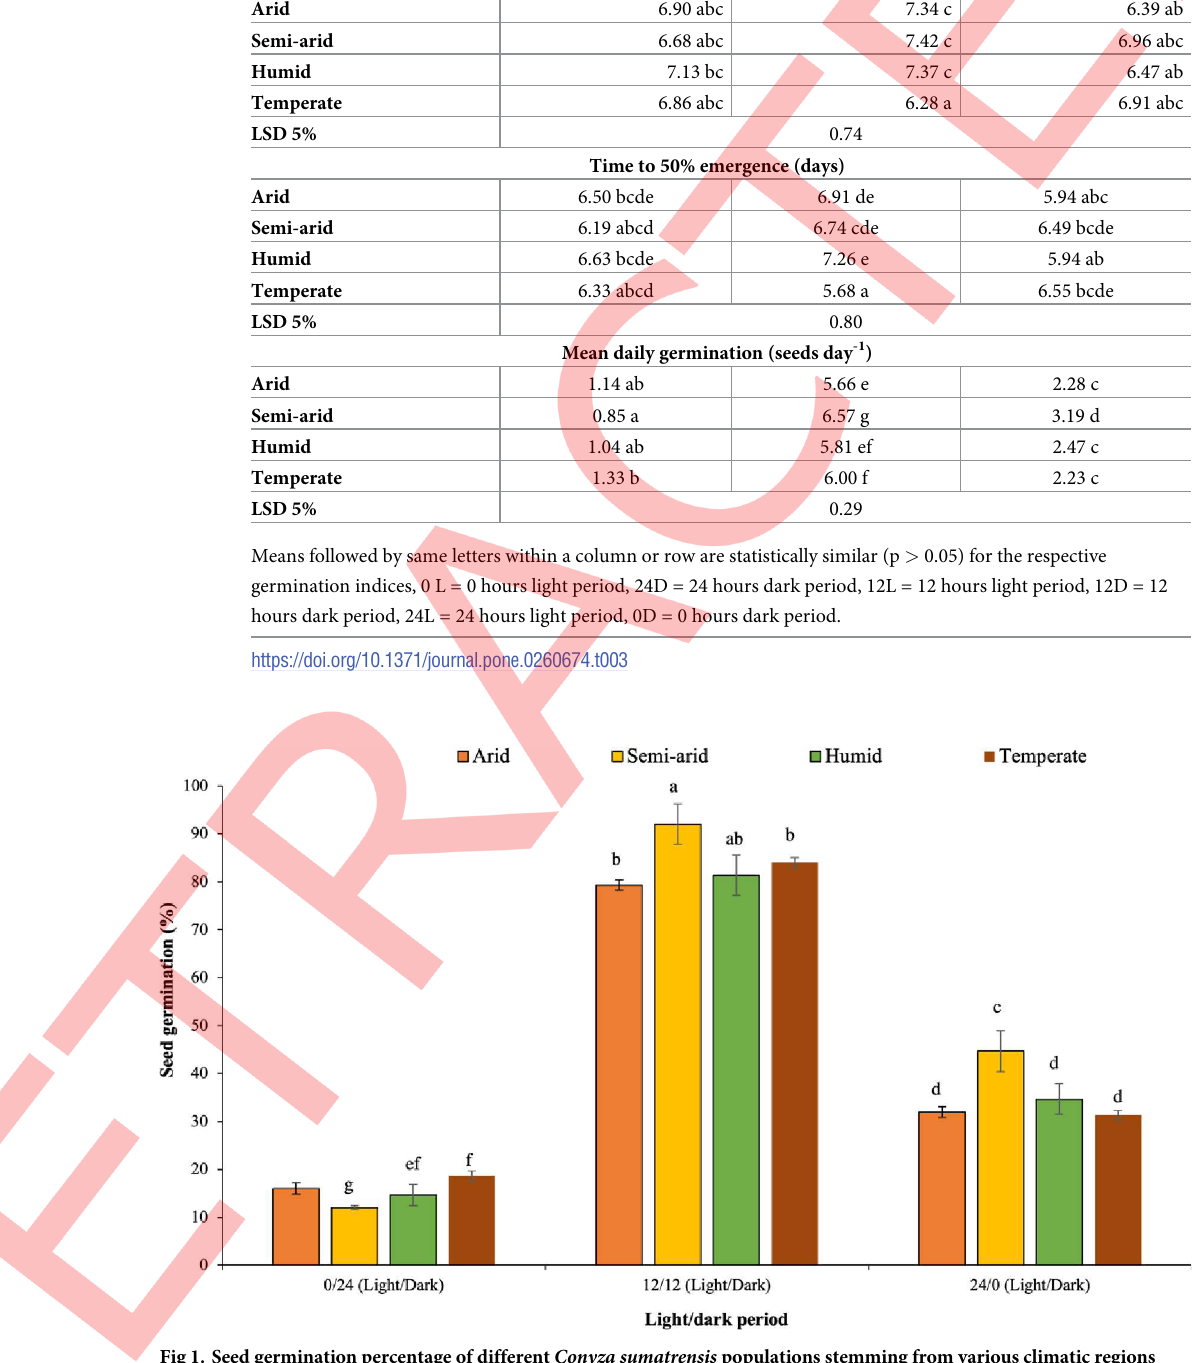
Fig 1. Seed germination percentage of different Conyza sumatrensis populations stemming from various climatic regions under different light and dark periods.